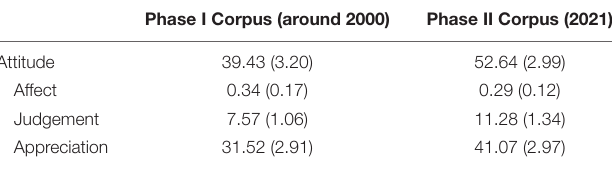
TABLE 2 | Attitude in the About Us texts: Means (standard